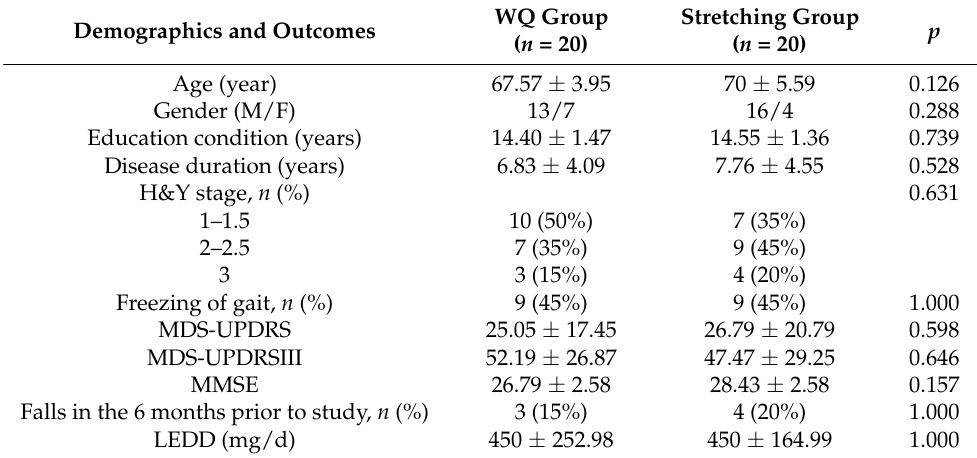
Figure 2. Flow diagram of the study. Table 1. Demographic characteristics and clinical outcomes.